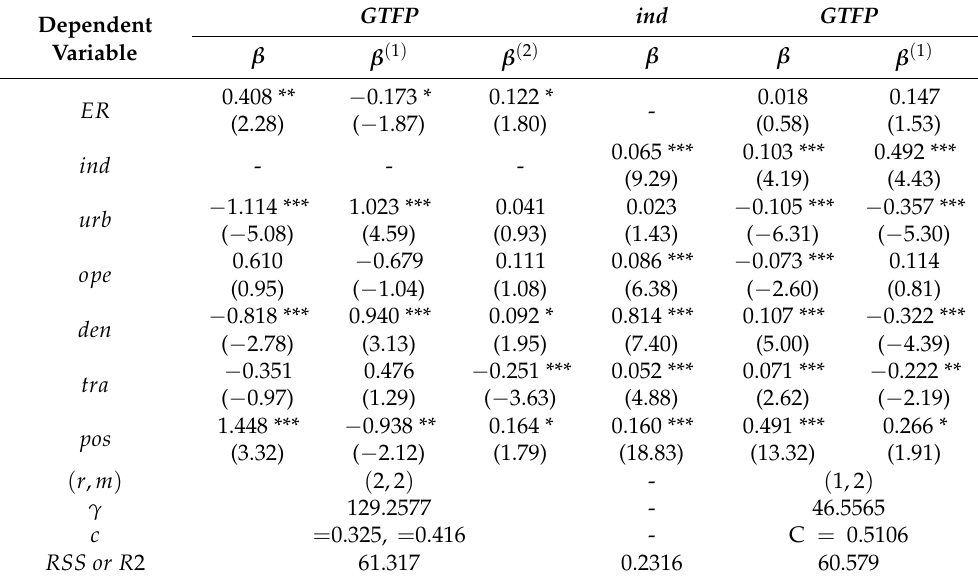
Table 7. The test results of the industrial-upgrading effect in policy guidance on